Question: Which visualization type does this figure use?
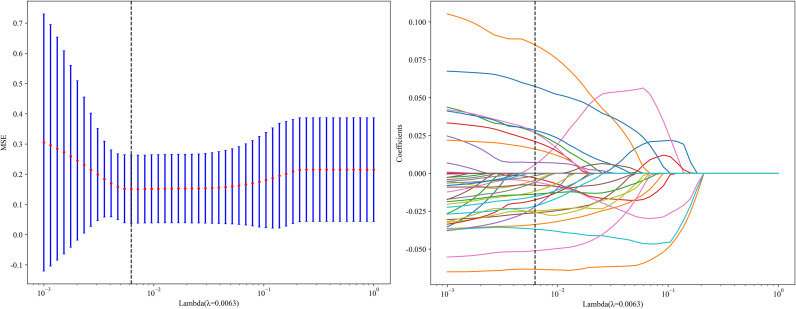
Answer: histogram